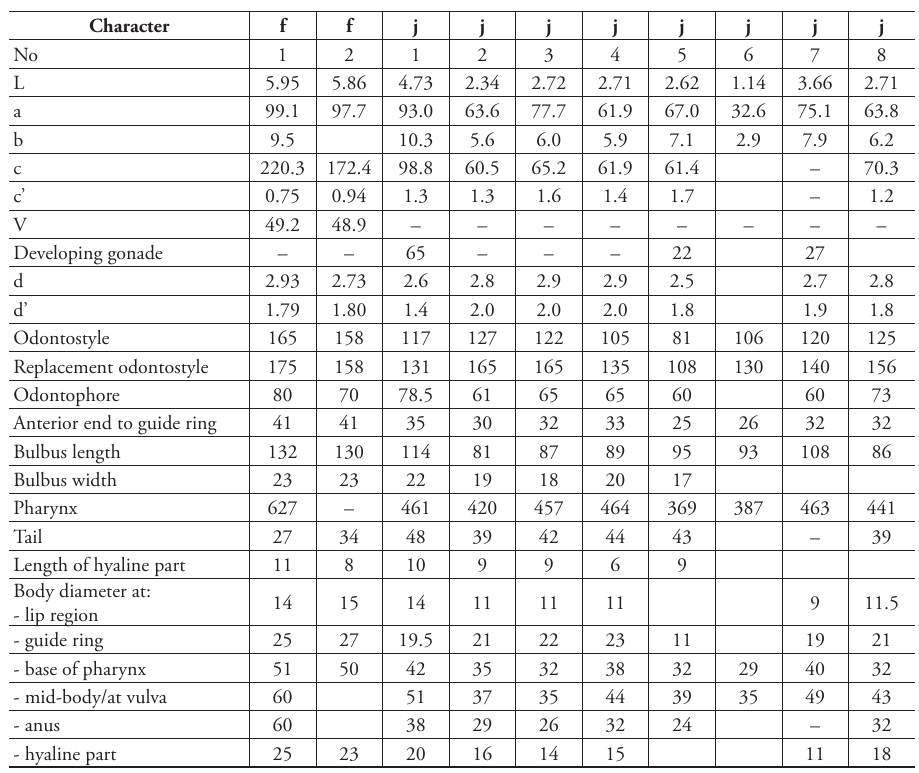
Table 3. Measurements of Longidorus piceicola females (f) from Cernica, and juveniles (j) from Bran, Braşov County, Romania showing different anomalies. All measurements in micrometers except body length